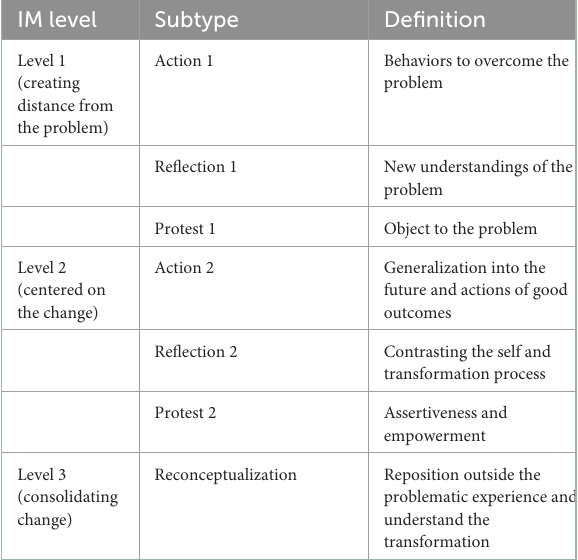
TABLE 1 Definition of innovative moments (Cardoso et al.,